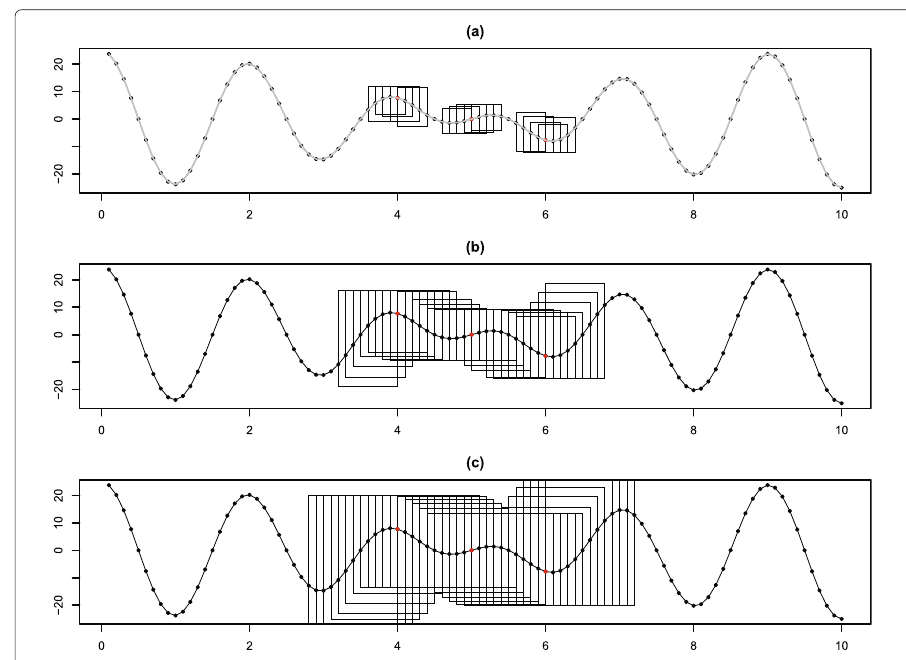
( X ) of signal X = 25cos ( 0.1 π t ) cos (π t ) at center points, t t i